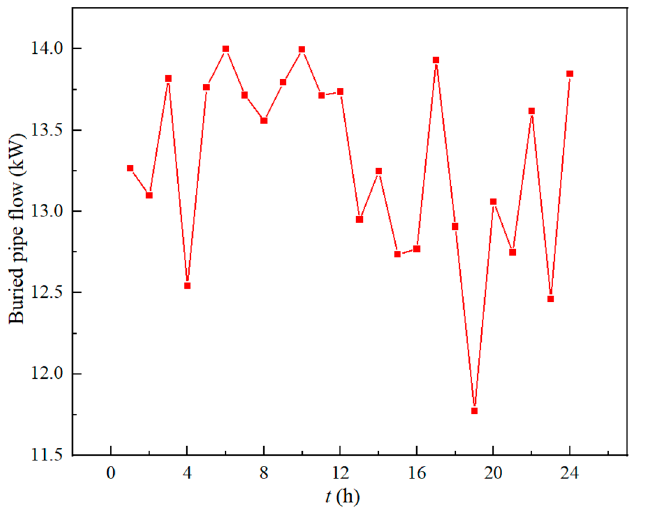
Figure 9. Buried pipe flow in each period when the objective function is system COP.